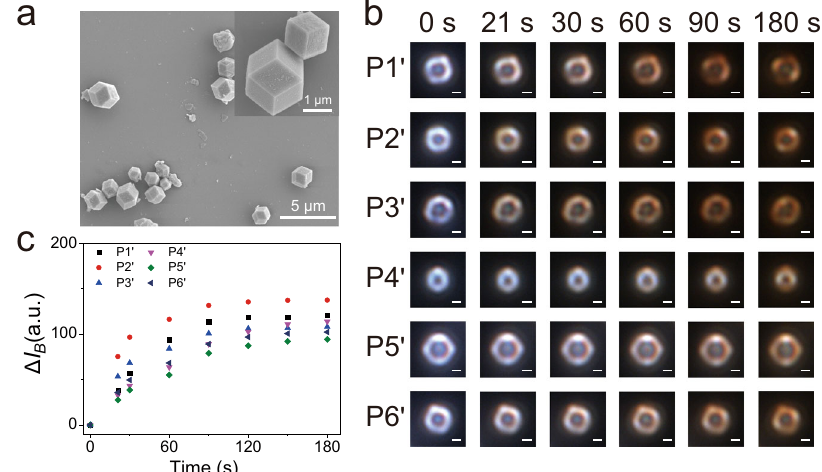
Fig. 6 Visually monitoring gaseous I 2 adsorption on individual ZIF-91 particles. a SEM image of ZIF-91 particles. b Time-resolved DFM images of gaseous I 2 adsorption on six representative ZIF-91 particles (scale bar: 1 μ m) and ( c ) the corresponding adsorption kinetic. △ I B represents the change of B value of the DFM